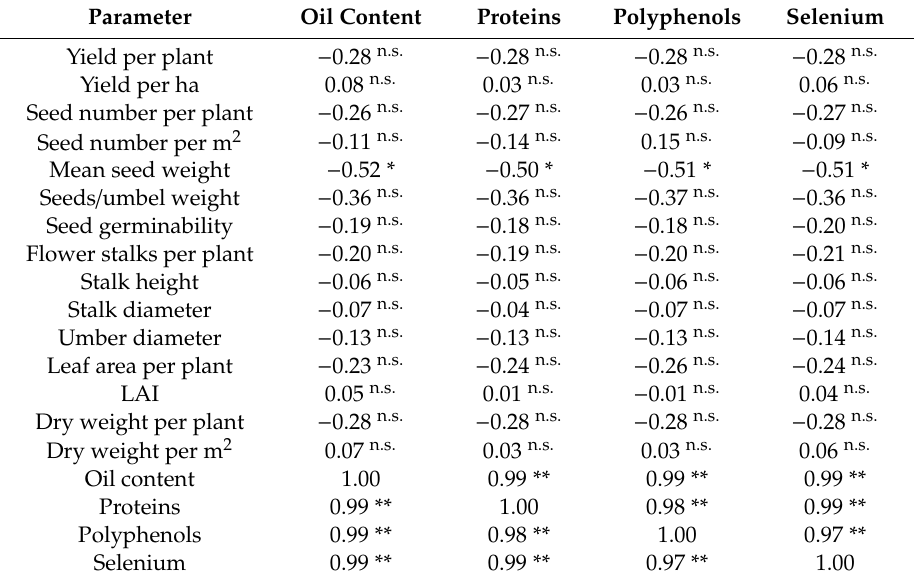
Table 7. Correlations between quality and yield, growth and biometrical